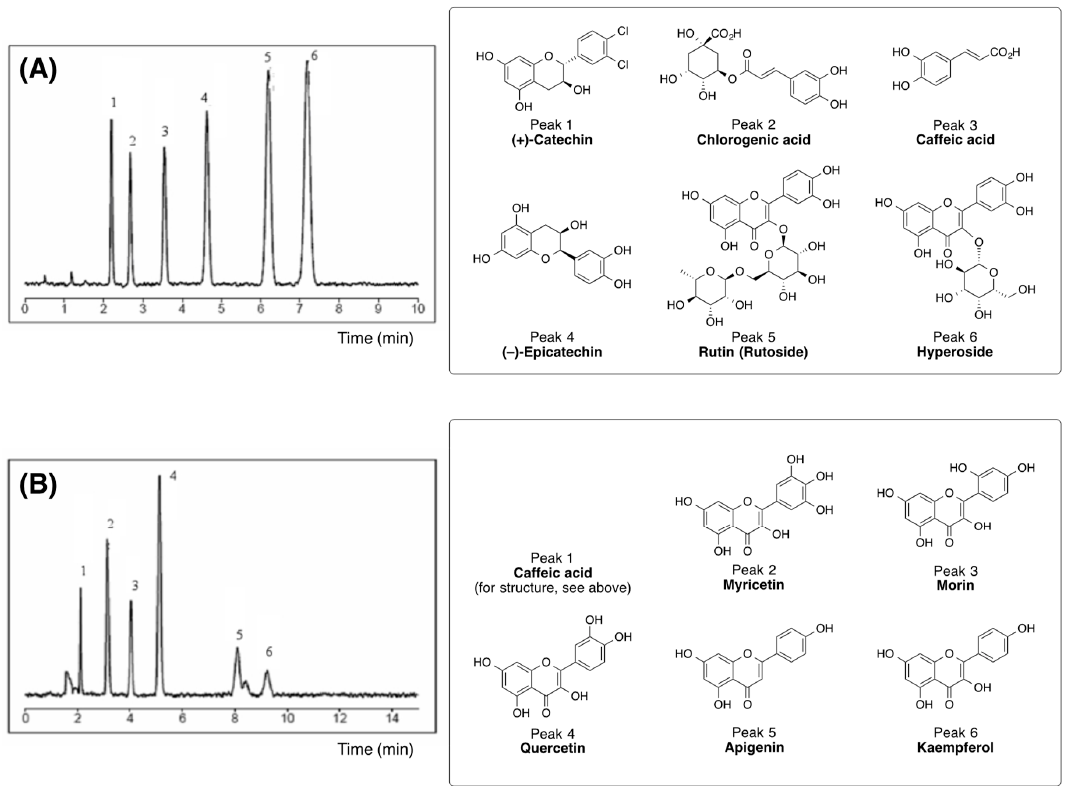
Figure 2. ( A ) Standard reverse phase high performance liquid chromatography (RP-HPLC) analysis of Geranium sanguineum L. extract using analytical method I with a linear gradient elution system (mobile phase A: water/methanol/formic acid, 74.7:25:0.3, v / v / v ; mobile phase B: acetonitrile/formic acid, 99.7:0.3, v / v ) at 270 nm and flow rate 1.0 mL/min [14]. ( B ) RP-HPLC separation of Geranium sanguineum L. extracts (obtained from ethyl acetate and n -butanol extraction) using separation method II with isocratic gradient elution system (mobile phase: water / acetonitrile (65:35, v / v , adjusted to pH 2.3 with ortho- phosphoric acid) at 254 nm and flow rate 1.0 mL / min [14]. The structures of the